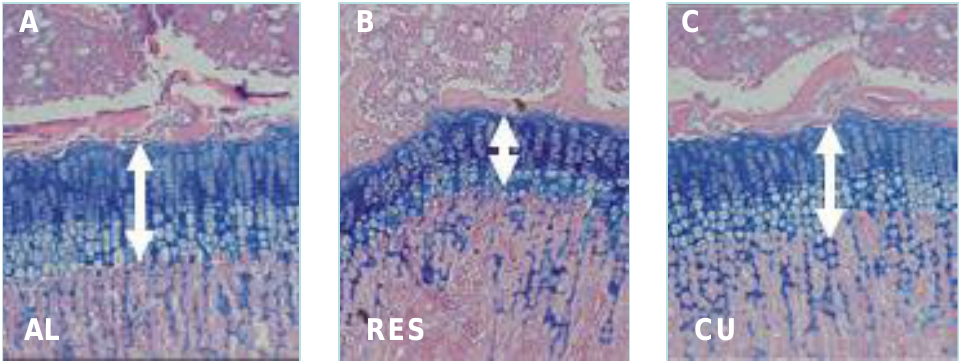
Figure 2. Effect of food restriction and re-feeding on the height of the